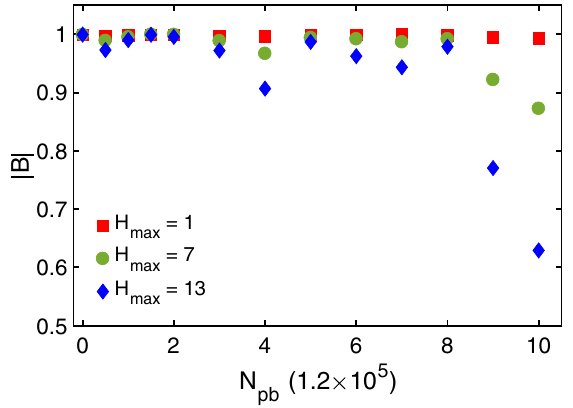
FIG. 10. Dependence of the bunching factors j B j on the number of electrons per microbunch for different radiation harmonics. The bunching factor is evaluated at s ¼ 2